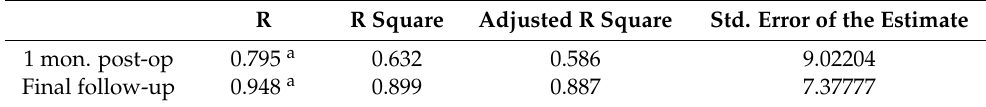
Table 7. Model summary of improvement in GTS-QOL score based on linear regression